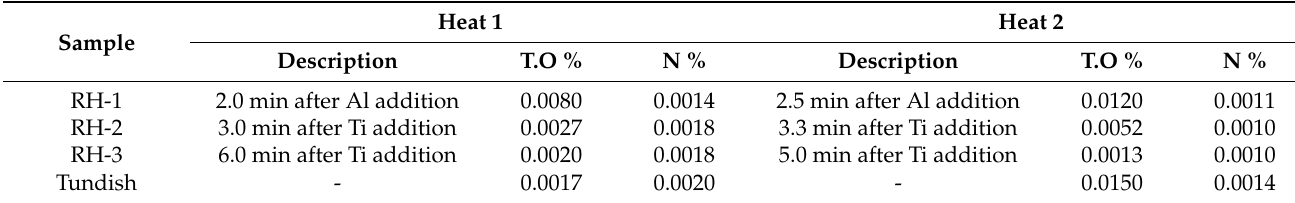
Table 1. Time of sampling and chemical composition of lollipop samples.